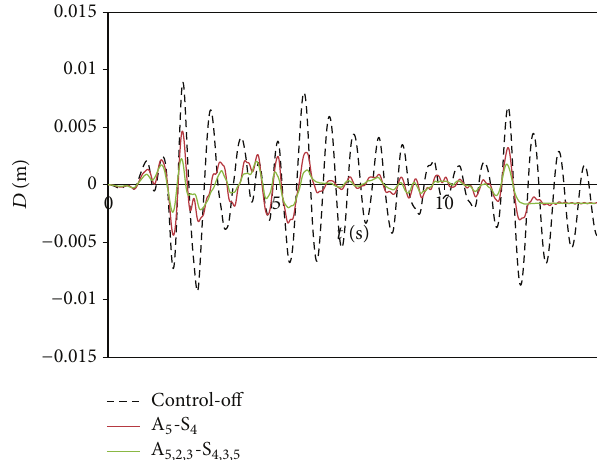
Figure 5: The time history displacement for the fifth-story of shear building excited by the Elcentro earthquake.